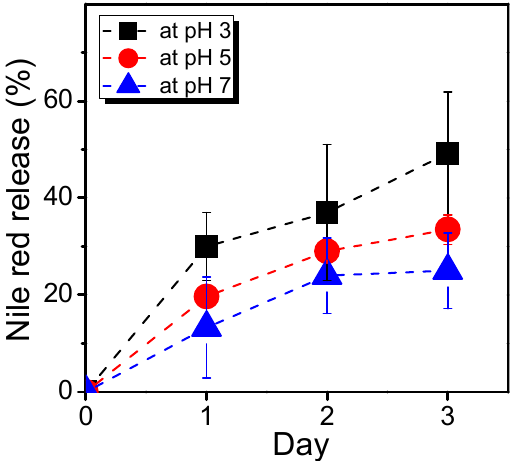
Figure 6. Release profiles of Nile red encapsulated by PVBPA 34 - g -PNVP 60 amphiphilic bottlebrush.